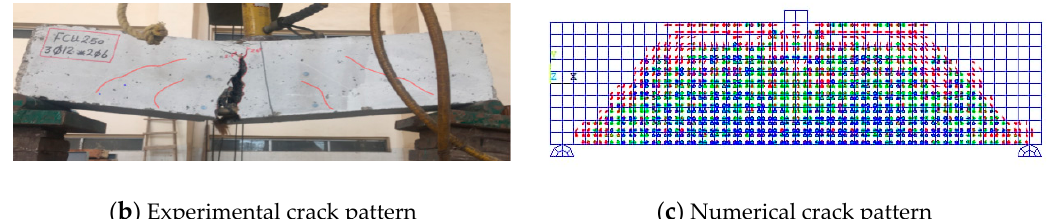
Figure 17. Beam B2 modeling.